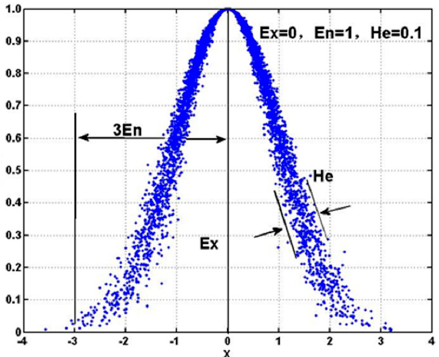
Figure 1. Normal cloud and digital features ( E x = 0, E n = 1, H e = 0.1 ).